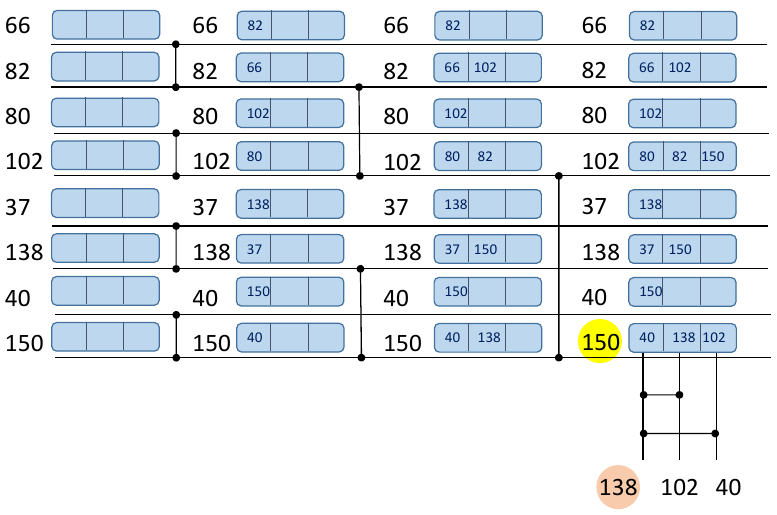
Figure 5. Network of comparators with memory for finding two largest data items: 150 (highlighted with yellow color) and 138 (highlighted with orange color).